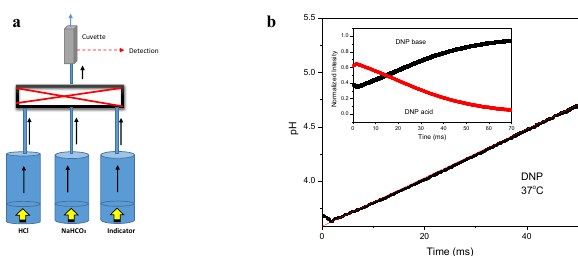
Fig. 2. (a) A stopped-flow setup for determination of carbonic acid (CA) acidity and lifetime while it spontaneously decomposes to H 2 O and CO 2 [1]. CA is generated by rapid acidification of bicarbonate HCO 3 - by HCl in the water mixtures case [5] and by HClO 4 in the methanol mixtures, then reacted in the same chamber with an acid-base indicator, either dinitrophenol (DNP) or methyl orange (MO) both having a comparable pK a to CA in water; pK a (MO) = 3.46 and pK a (DNP) = 4.07 at 20 o C and in methanol for DNP pK a = 7.86. (b) pH versus time plot using DNP as the acid-base pH indicator. Inset: The absorption change in the concentration of the base (black line) and acid (red line) forms of the DNP pH indicator versus time measured in water. The pH was found by taking the ratio of the base to acid concentrations calculated from the absorbance data using the Beer-Lambert law. The lifetime of CA is found from the time dependence of the solution pH which changes as the decomposition reaction of CA progresses and de-acidifies the solution by removing CA from the solution. The pK a of CA is found by extrapolating the almost linear dependence of the solution pH vs. time to time zero at which the pK a of CA is equal to the pH because the concentration of the bicarbonate anion at time zero was set to be equal to the concentration of CA (the Henderson- Hasselbalch equation